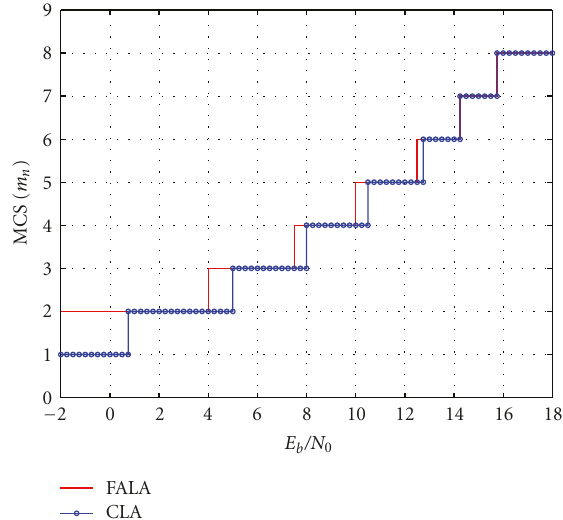
Figure 8: The corresponding MCS schemes versus SNR values adopted in the goodput comparison as in Figure 7.